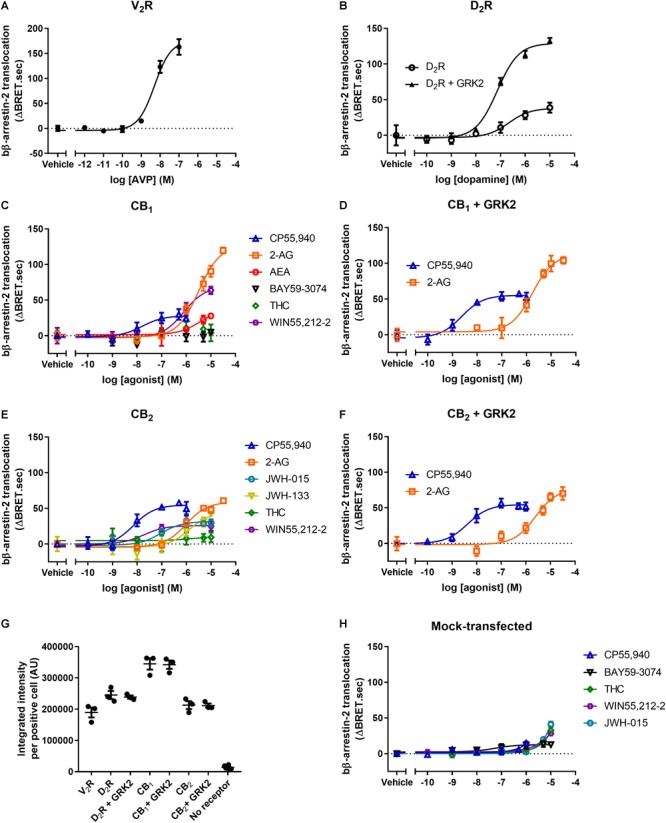
bβ-arrestin-2 translocation to V2R, D2R, CB1, and CB2. bβ-Arrestin-2 translocation to plasma membrane in cells expressing (A) V2R stimulated with AVP, (B) D2R with or without co-expressed GRK2 stimulated with dopamine, (C) CB1 stimulated with CP55,940, 2-AG, AEA, BAY, THC, and WIN55,212-2, (D) CB1 with co-expressed GRK2 stimulated with CP55,940 and 2-AG, (E) CB2 stimulated with CP55,940, 2-AG, JWH-015, JWH-133, THC, and WIN55,212-2, and (F) CB2 with co-expressed GRK2 stimulated with CP55,940 and 2-AG. (G) Receptor expression of V2R, D2R, D2R+GRK2, CB1, CB1+GRK2, CB2, CB2+GRK2, and no-receptor transfected controls in cells used in experiments (A–G). Receptor expression per cell was quantified in cells positive for expression by ICC. (H) bβ-Arrestin-2 translocation to plasma membrane in mock-transfected cells. Error bars are ±standard deviation of representative data with three technical replicates (A–F), or standard error of the means from three independent biological replicates (G,H).